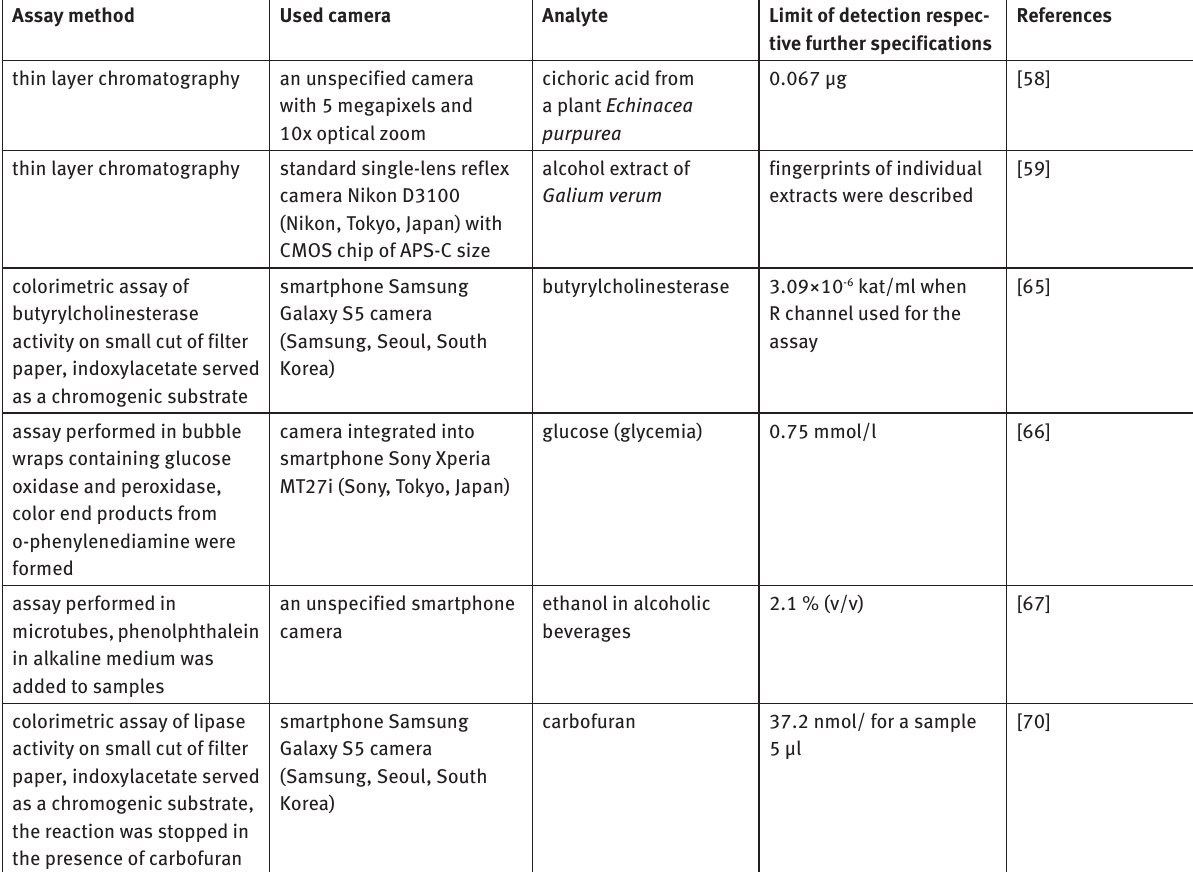
Table 1 Thin layer methods with digital camera on the output Assay